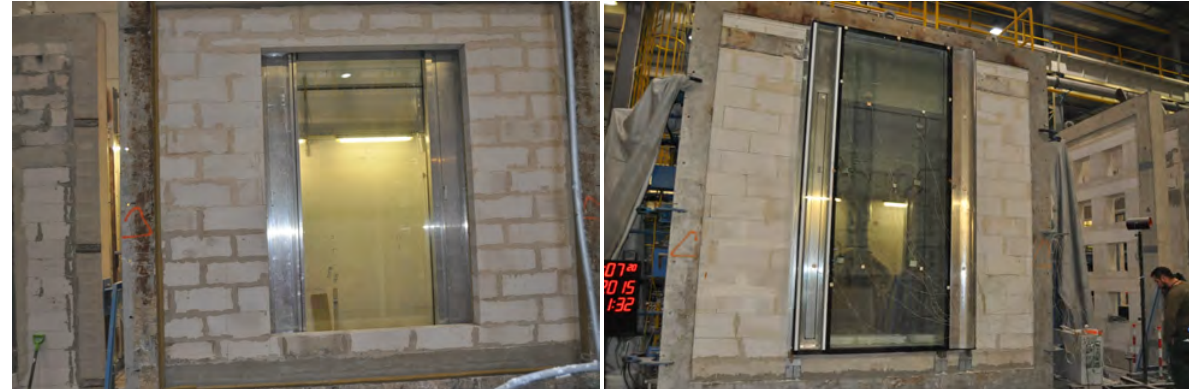
Figure 6: The view of the exposed (left side) and unexposed (right side) surface of tested specimen prior to the test.